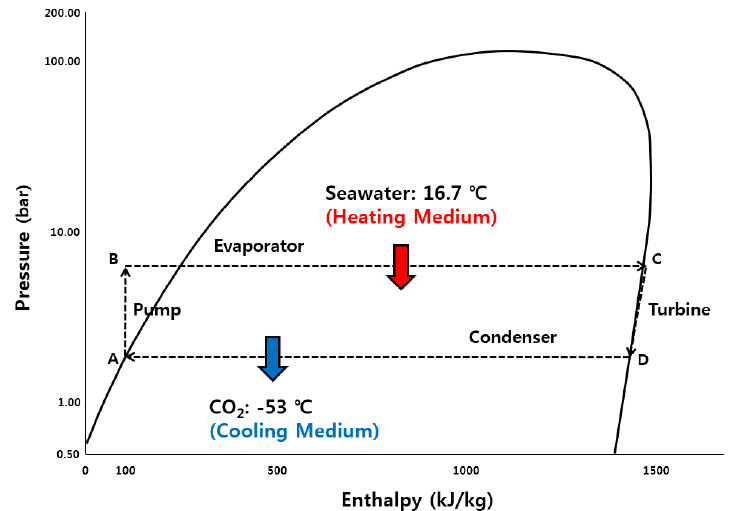
Figure 3. P-h diagram of working fluid.